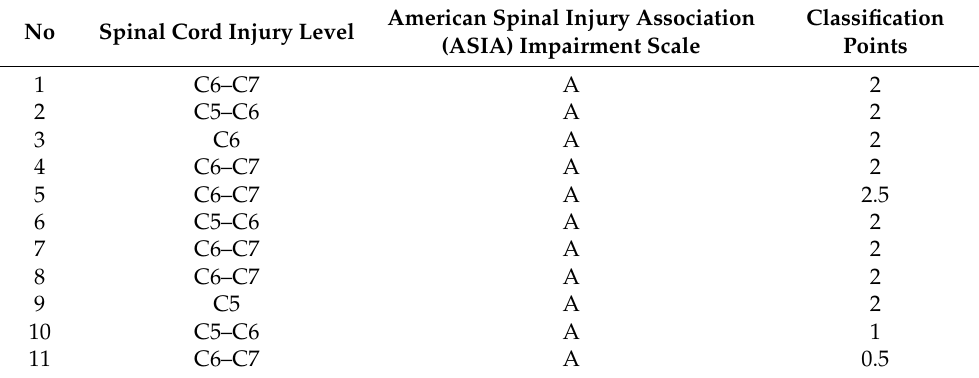
Table 1. Classification points, spinal cord injury level, American Spinal Injury Association (ASIA) Impairment Scale of the subjects with spinal cord injury